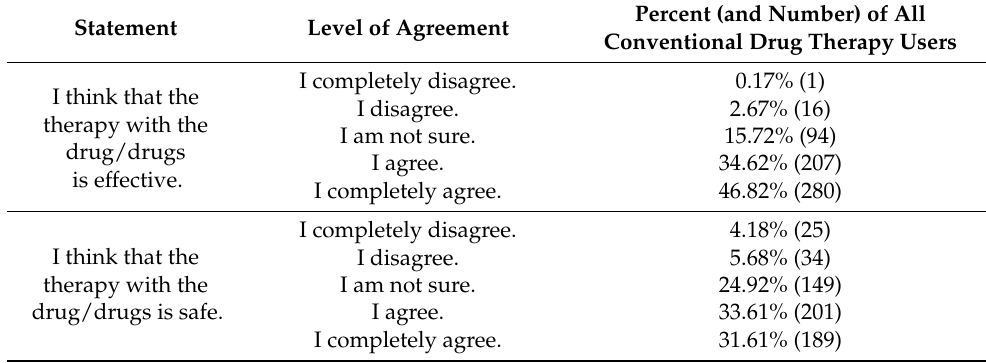
Table 3. The opinion on the efficacy and safety of the conventional drug